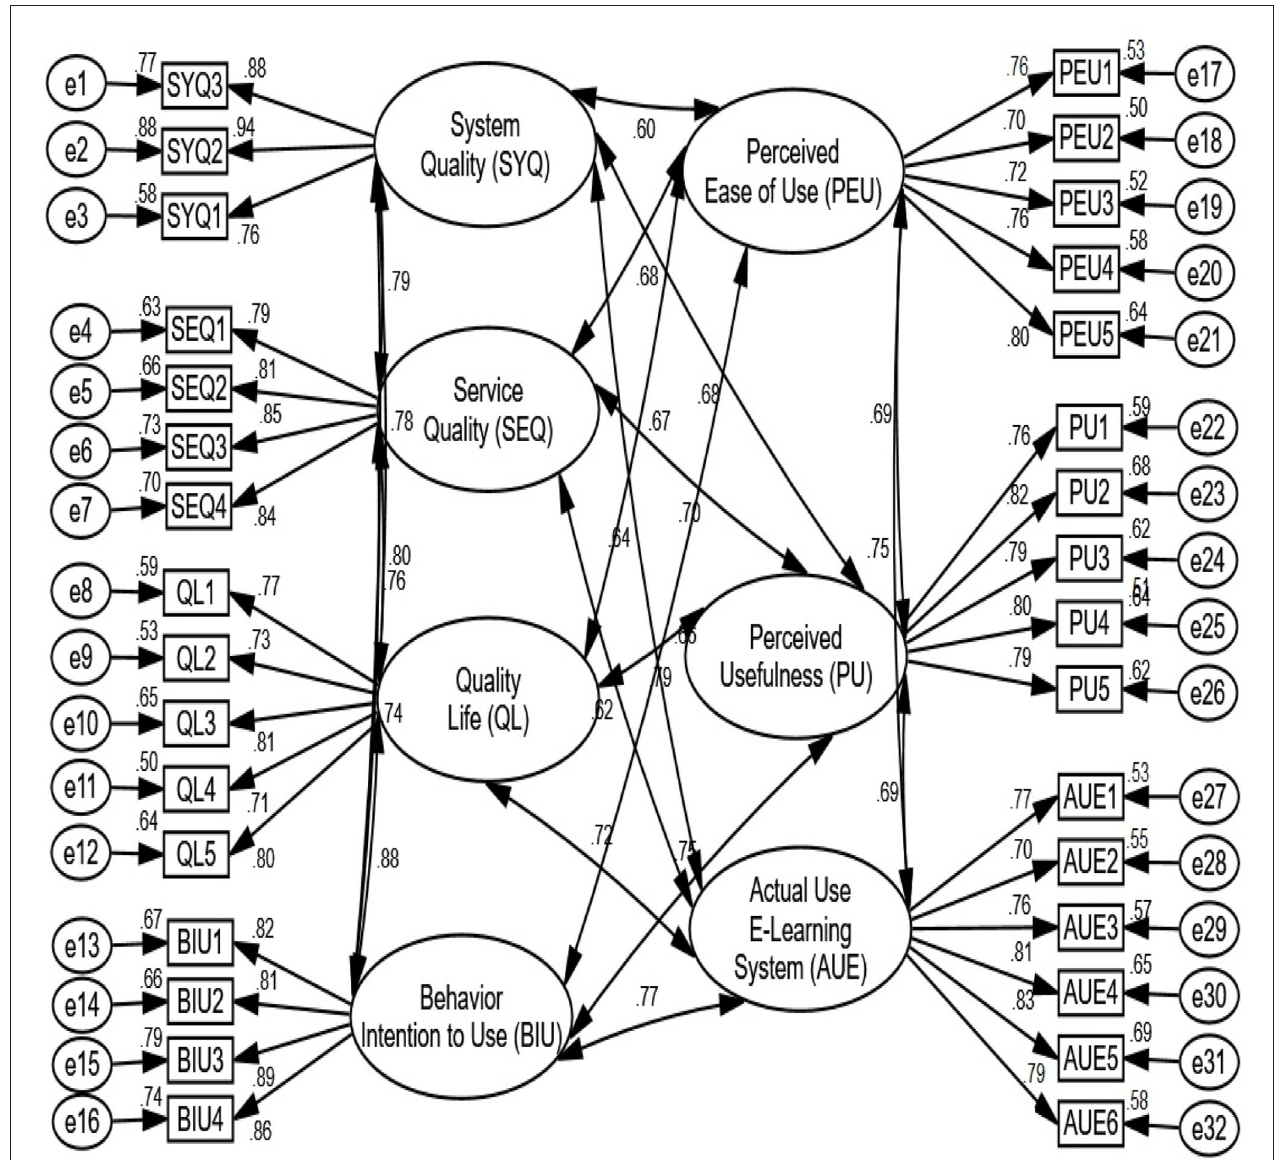
FIGURE 2 | Measurement